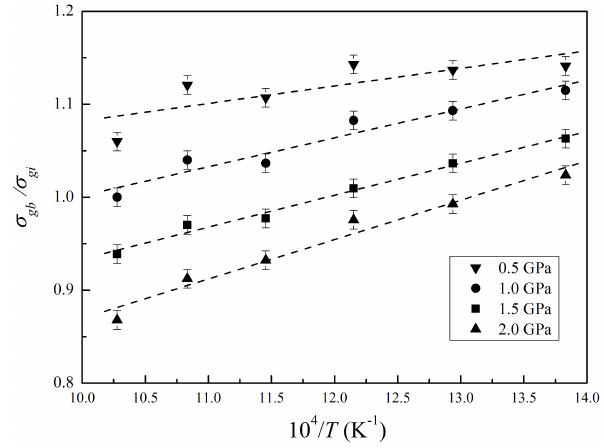
Figure 7. Grain boundary/grain interior conductivity ( σ gb /σ gi ) ver- sus reciprocal temperature ( T − 1 ) under conditions of 1.0GPa and 723–973K. The ratio represents the leading role of grain boundary or grain interior conductivity in the conduction process.